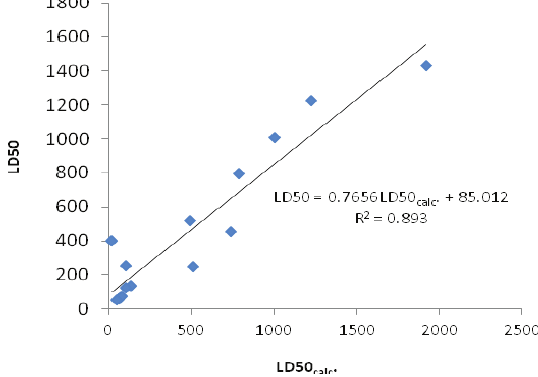
Figure 6. The plot of LD50 vs. LD50calc. by similarity clusters.